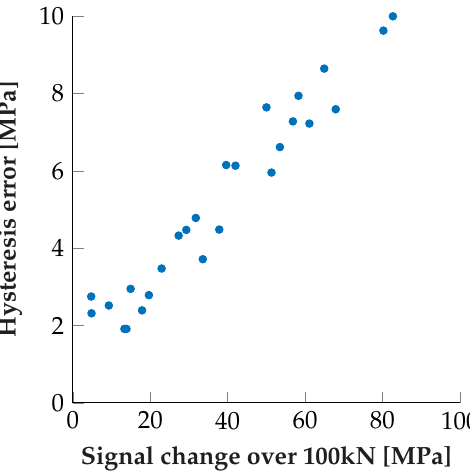
Figure 15. Correlation of hysteresis error to signal swing of two sensor pairs at 13 different roller